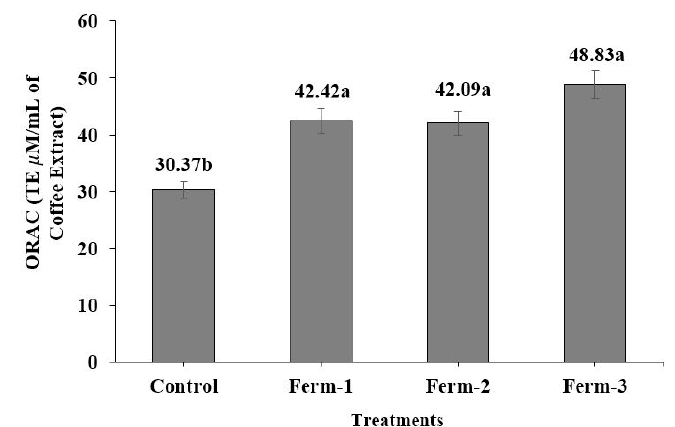
Figure 5. The average of oxygen radical absorbance capacity of fermented coffee (24 h and 48 h). The bars with different letters indicate a significant difference ( p < 0.5) among treatments.